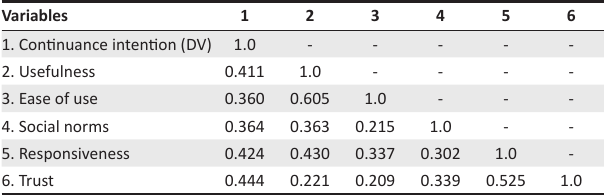
TABLE 3: Correlation matrix for usefulness, ease of use, social norms, responsiveness and trust on OBC continuance intention ( N =